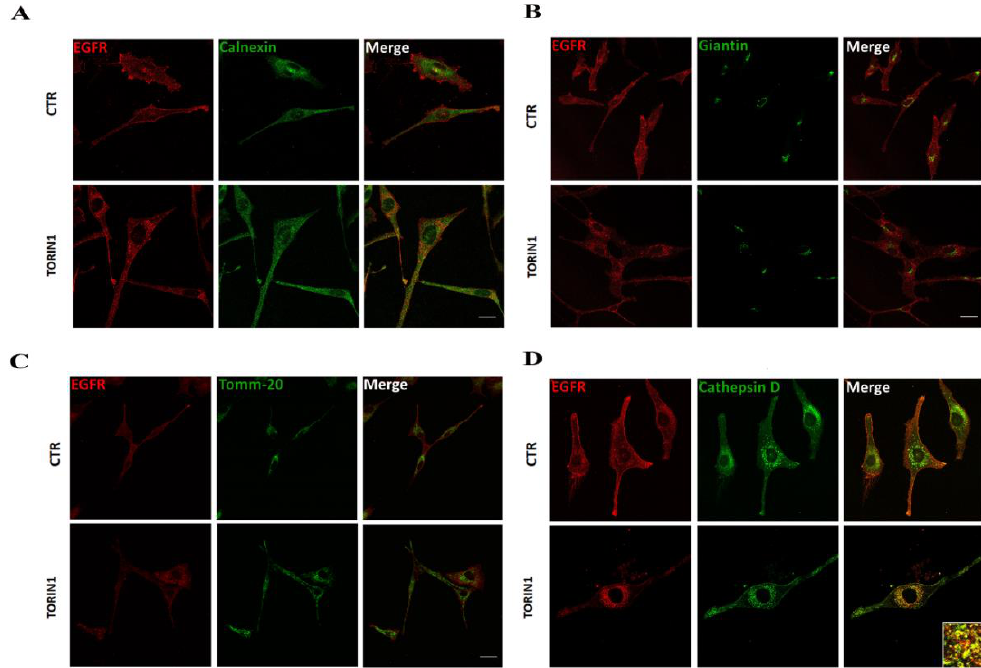
Figure 3. EGFR is delivered to lysosomes upon mTOR inhibition in GBM cells. U87MG treated with Torin1 for 24h or untreated (CTR) were subjected to immunocytochemistry and confocal analysis for EGFR (red) and for different subcellular markers (green): Calnexin for endoplasmic reticulum ( A ), Giantin for Golgi cisternae ( B ), Tomm-20 for mitochondria ( C ) and Cathepsin D for lysosomes ( D ). The images showing the merge of the two signals are shown in the right panels. Inset containing a high magnification view of the merge image is also shown. Scale bar, 30 μM. Colocalisation was assessed by calculating the Pearson’s correlation coefficient r (mean r in D: CTR, 0.2 ± 0.03; Torin1, 0.75 ± 0.06).